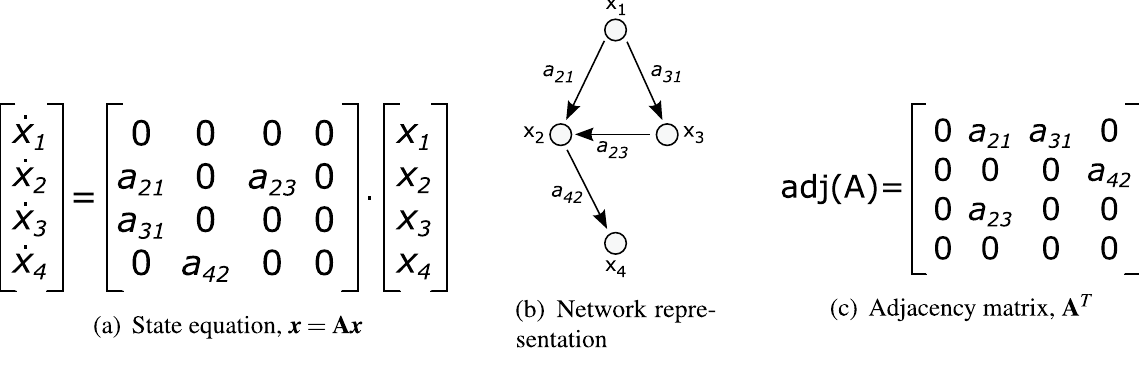
Figure 1. Representations of a state-transition matrix. ( a ) Illustrative state equation with four state variables. ( b ) Network representation of the dynamical system. ( c ) The adjacency matrix of the network is the transpose of the state-transition